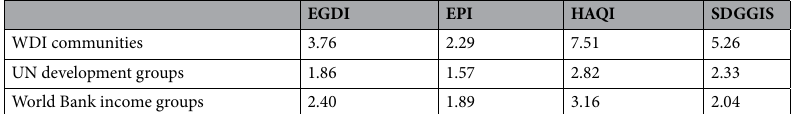
Table 3. Comparison between resolution ratios of ranked indexes with respect to the partitions determined by WDI communities, UN development groups, and World Bank income groups. Only results for rankings with significantly separated community index distributions ( R > 1 ) are